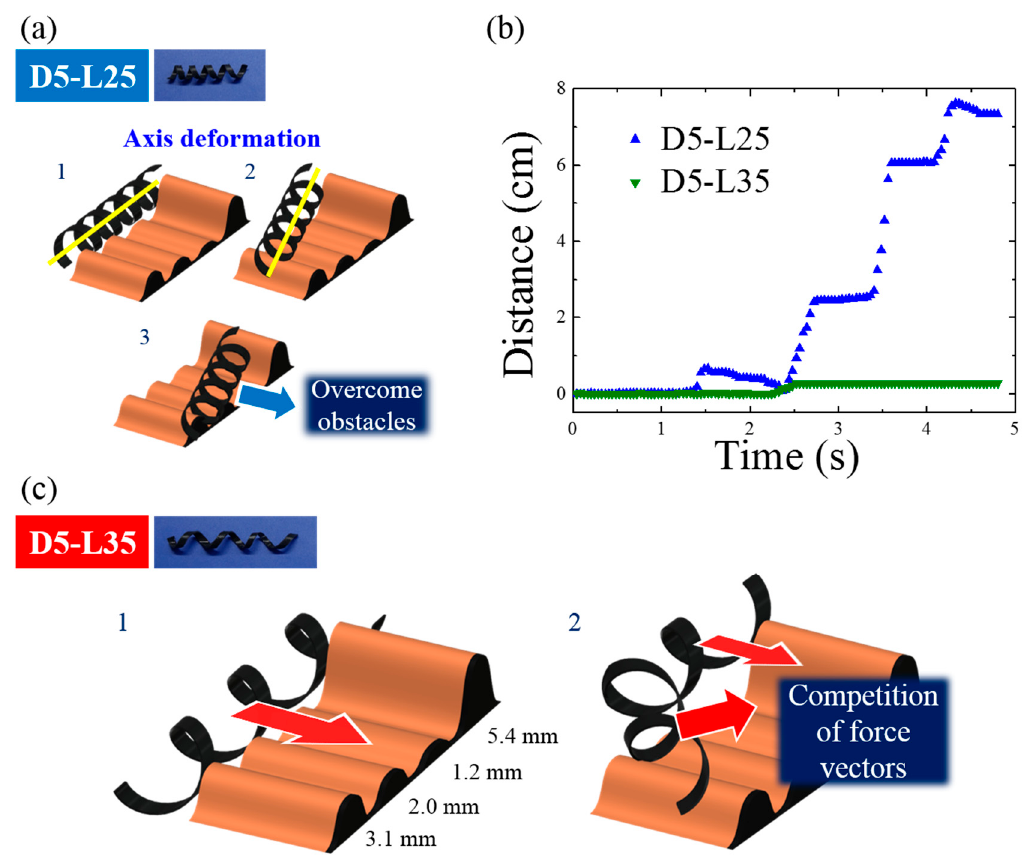
Figure 8. ( a ) Representative scheme for magnetomotility of D5-L25 at four wrinkles with di ff erent heights; ( b ) Time-resolved magnetomotility of helical soft robots for D5-L25 and D5-L35 at four di ff erent wrinkles; ( c ) Representative scheme for magnetomotility of D5-L35 at four di ff erent wrinkles.